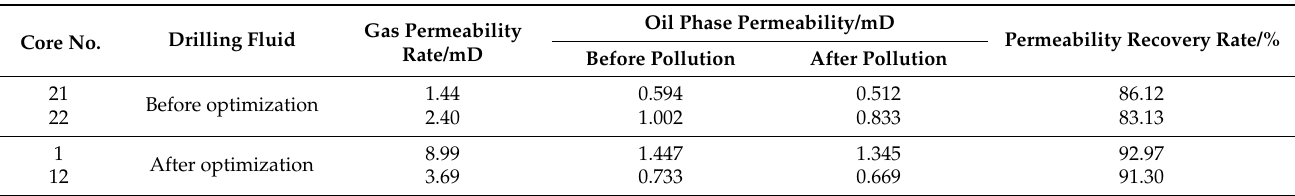
Table 8. Evaluation of plugging material particle matching between before/after optimization of solid-free organic salt drilling